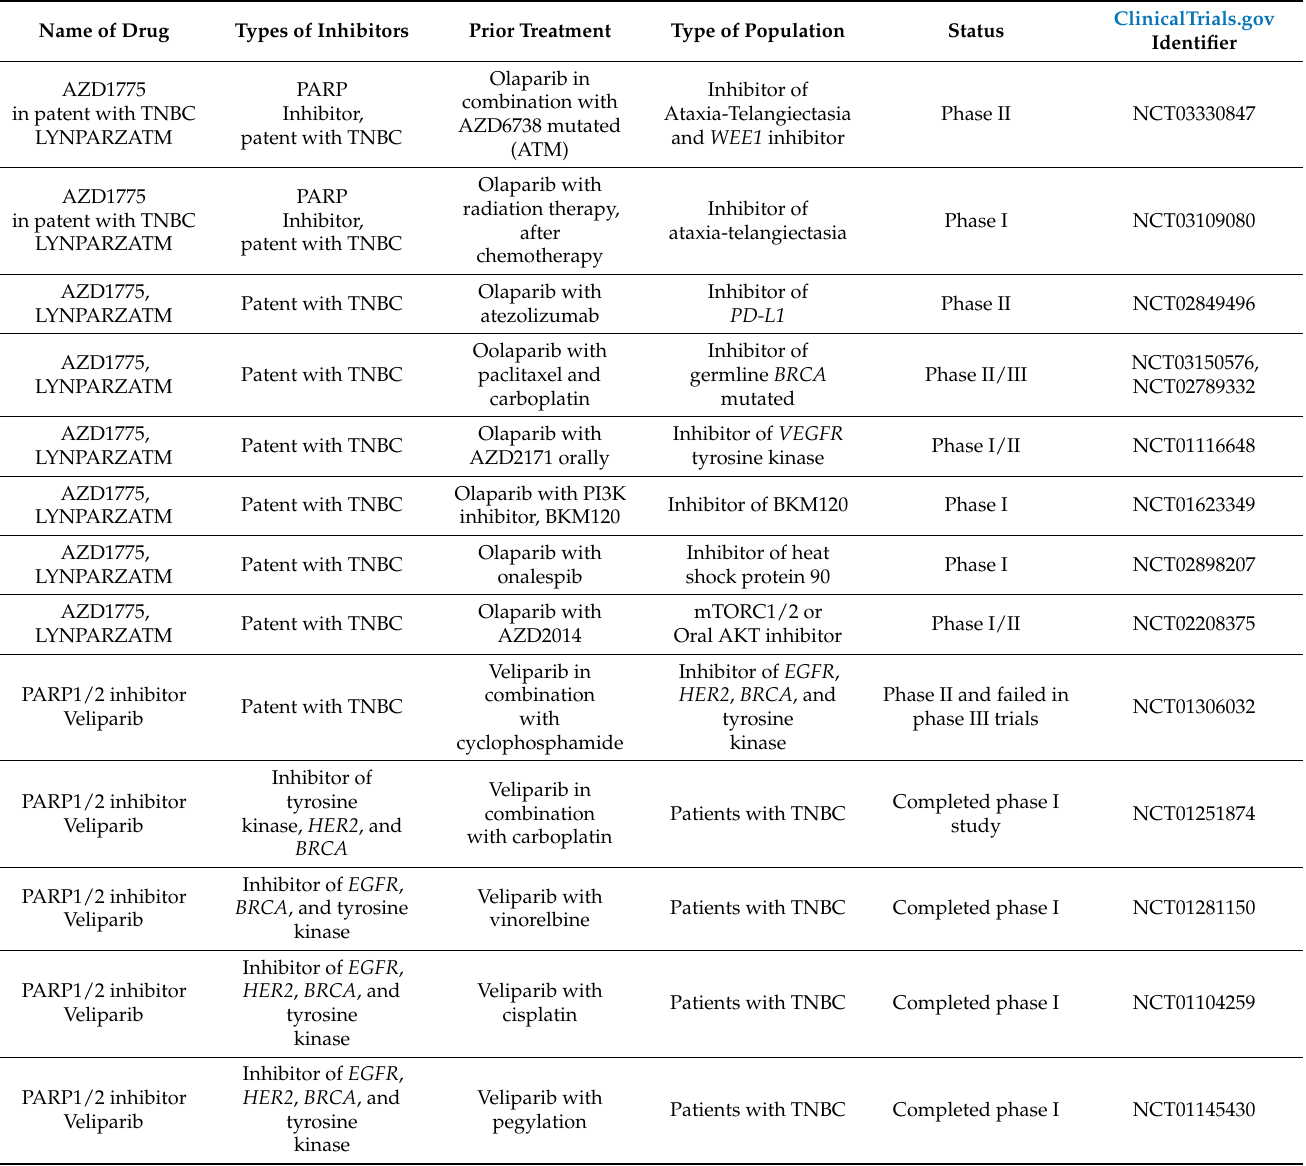
Table 3. Clinical Trials of PARP Inhibitors in